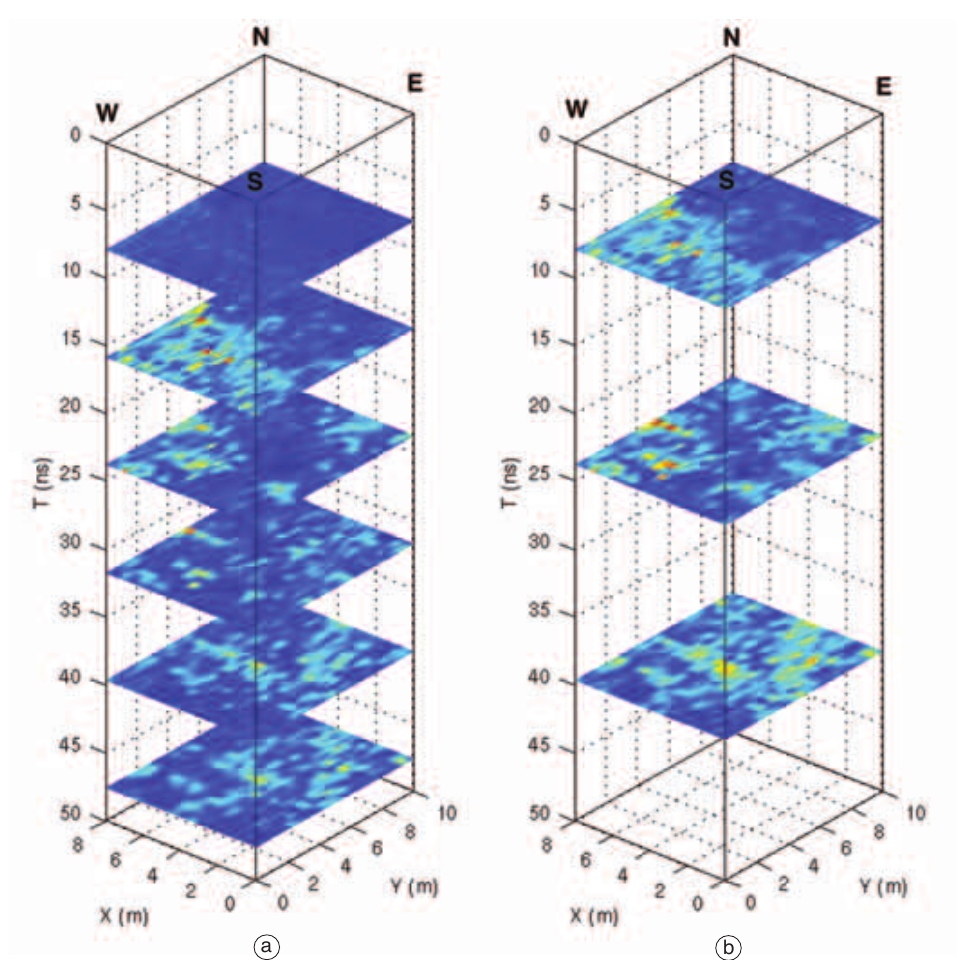
a Fig. 8a,b. Zone B. Time slices obtained averaging the absolute amplitude of the data within different time windows: 8 ns (a) and 16 ns (b).